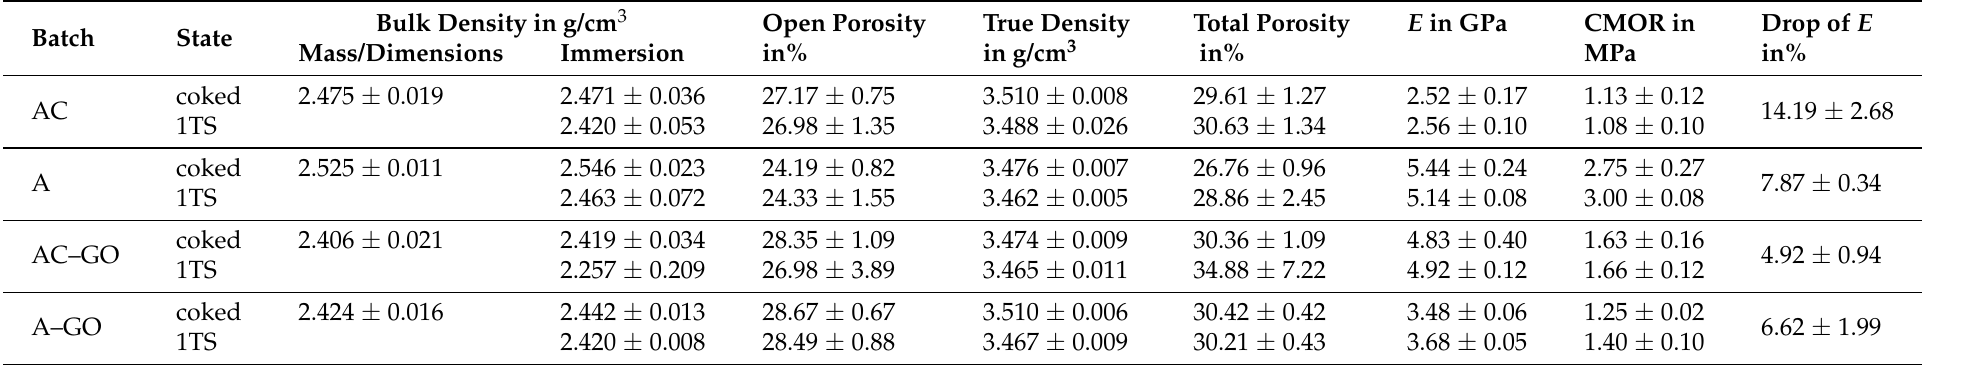
Table 3. Means and standard deviations of the bulk and true densities, the open and total porosities, the Young’s modulus E and its drop with thermal shock and the cold modulus of rupture (CMOR) in dependence on the graphene oxide addition (–GO), the graphite consideration in the aggregate size distribution calculation (AC = graphite included; A = graphite not included) and the state (1TS—once thermally